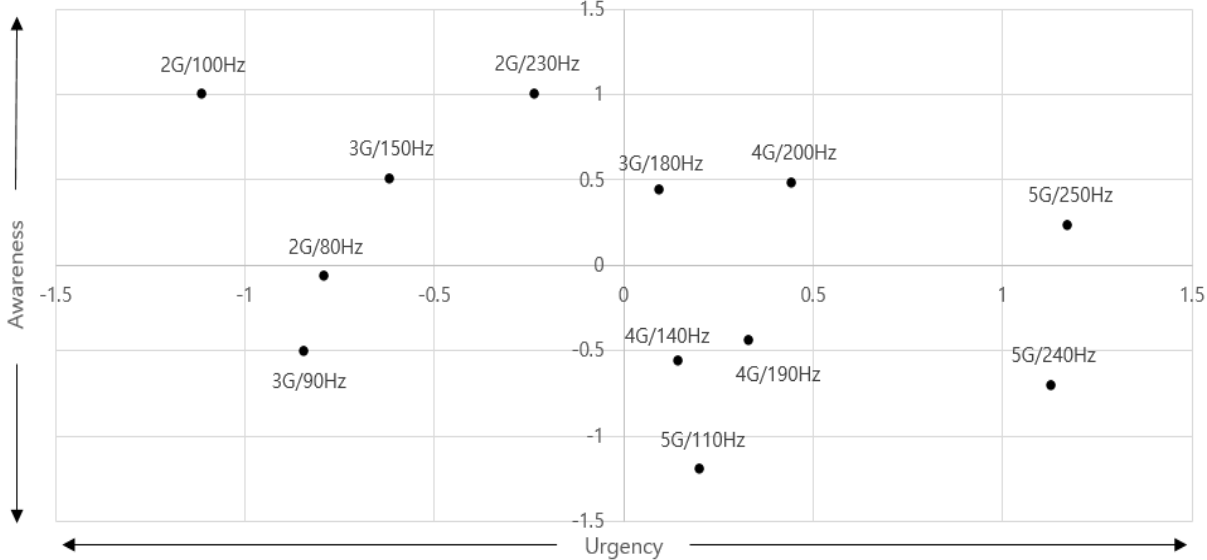
Figure 4. Emotional map of “urgency” and “awareness”.